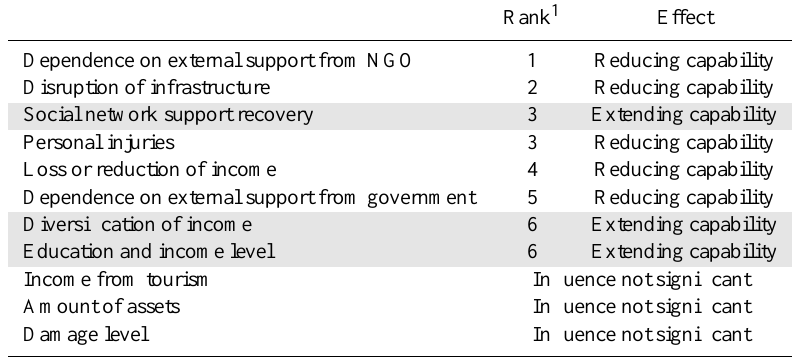
Table 1. Influence of sensitivity and resilience elements on the recovery capabilities of households (Willroth et al.,